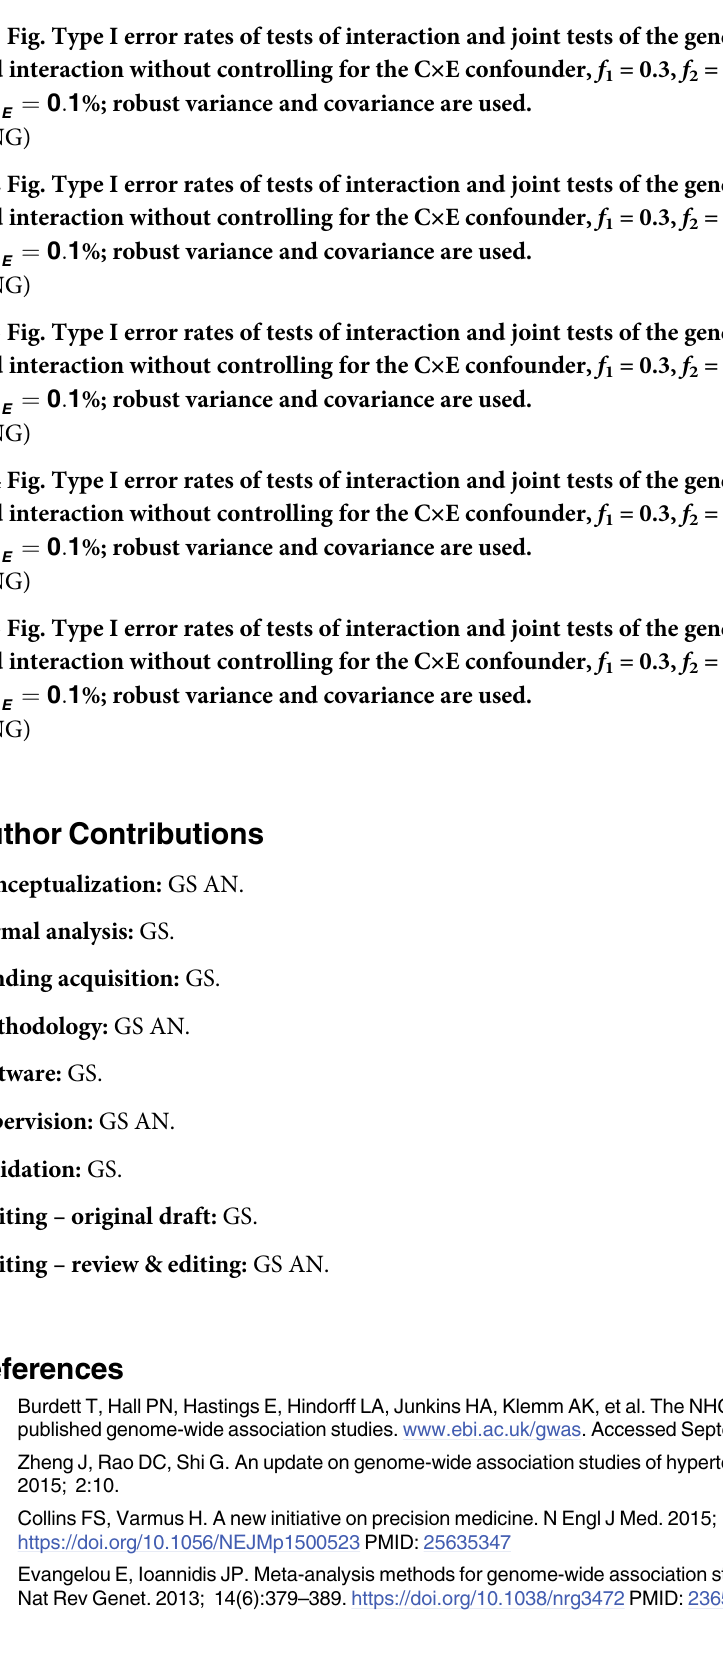
= 0.3, f = 0.1, and 1 2 = 0.3, f = 0.2, and 1 2 = 0.3, f = 0.3, and 1 2 = 0.3, f = 0.4, and 1 2 = 0.3, f = 0.5, and 1 2